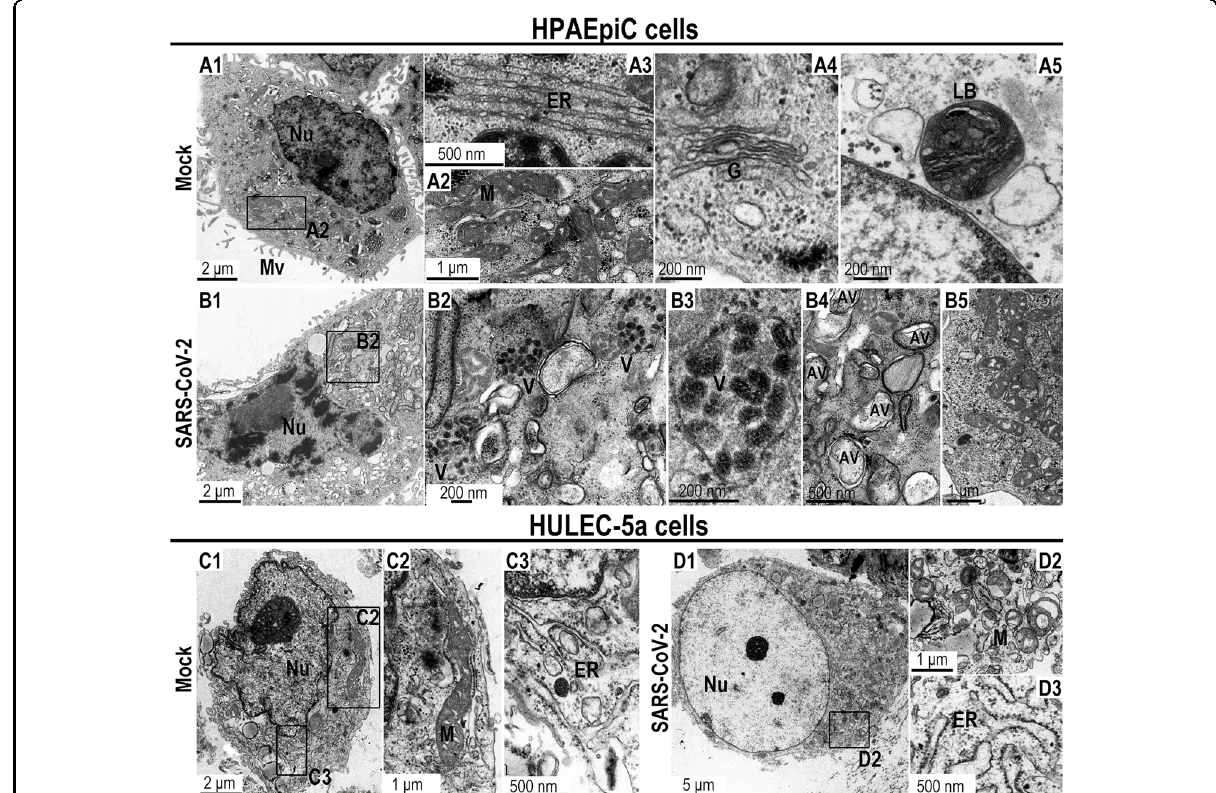
Fig. 7 TEM analysis of mock- and SARS-CoV-2-infected cells from alveolar co-culture system. a TEM micrographs of HPAEpiC cells of mock- infected group. a1 The overall image of the HPAEpiC cell. The area indicated by black box was enlarged in a2 . a2 The micrograph of mitochondria (M) of HPAEpiC cell. a3 The micrograph of smooth endoplasmic reticulum (ER) of HPAEpiC cell. a4 The micrograph of Golgi apparatus (G) of HPAEpiC cell. a5 The micrograph of lamellar body (LB) within cell body. b TEM micrographs of HPAEpiC cells of SARS-CoV-2-infected group. b1 The overall image of the infected cell. The area indicated by the black box is enlarged in b2 . b2 The micrograph of clusters of virus particles (V) within cell body. b3 Enlarged image of virus indicated in b2 . b4 A large amount of autophagic vacuoles (AV) in the infected HPAEpiC cells. b5 The micrograph of fragmented mitochondria (M) in the infected HPAEpiC cells. c TEM micrographs of HULEC-5a cells of mock-infected group. c1 The overall image of the HULEC-5a cells. The areas indicated by black boxes were enlarged in c2 and c3 , respectively. c2 The micrograph of mitochondria in the mock- infected HULEC-5a cells. c3 The micrograph of rough endoplasmic reticulum (ER) in mock-infected HULEC-5a cells. d TEM micrographs of HULEC-5a cells of SARS-CoV-2-infected group. d1 The overall image of the HULEC-5a cells. The areas indicated by black box were enlarged in d2 . d2 The micrograph of fragmented mitochondria (M) with swollen cristae in HULEC-5a cells of SARS-CoV-2-infected group. d3 The micrograph of dilated rough endoplasmic reticulum (ER) in HULEC-5a cells of SARS-CoV-2-infected group. Nu: nucleus; Mv: microvilli; M: mitochondria; ER: endoplasmic reticulum; G: Golgi apparatus; LB: lamellar body; V: virus particle; AV: autophagic vacuole. Three independent experiments were performed ( n =